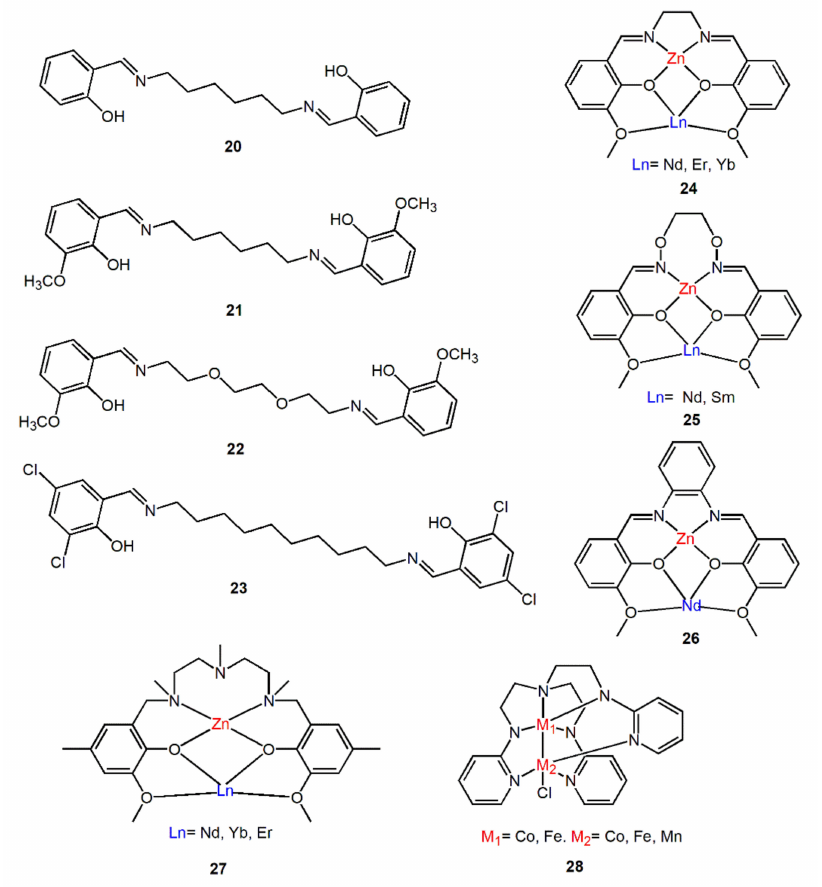
Figure 8. Some Schiff base bridging ligands and complexes mentioned in this